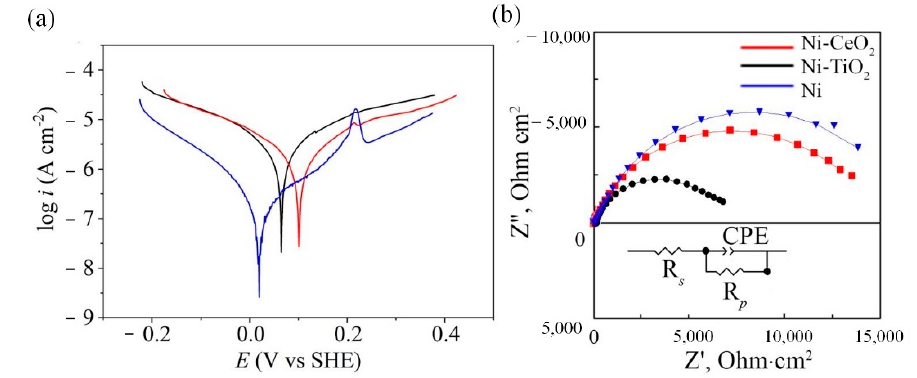
Figure 8. Potentiodynamic polarization curves ( a ) and Nyquist EIS plots ( b ) of Ni, Ni-TiO 2 , and Ni-CeO 2 coatings in 0.5 M NaCl solution and equivalent circuit, used for EIS data analyses. Table 6. Electrochemical parameters extracted from potentiodynamic polarization curves.